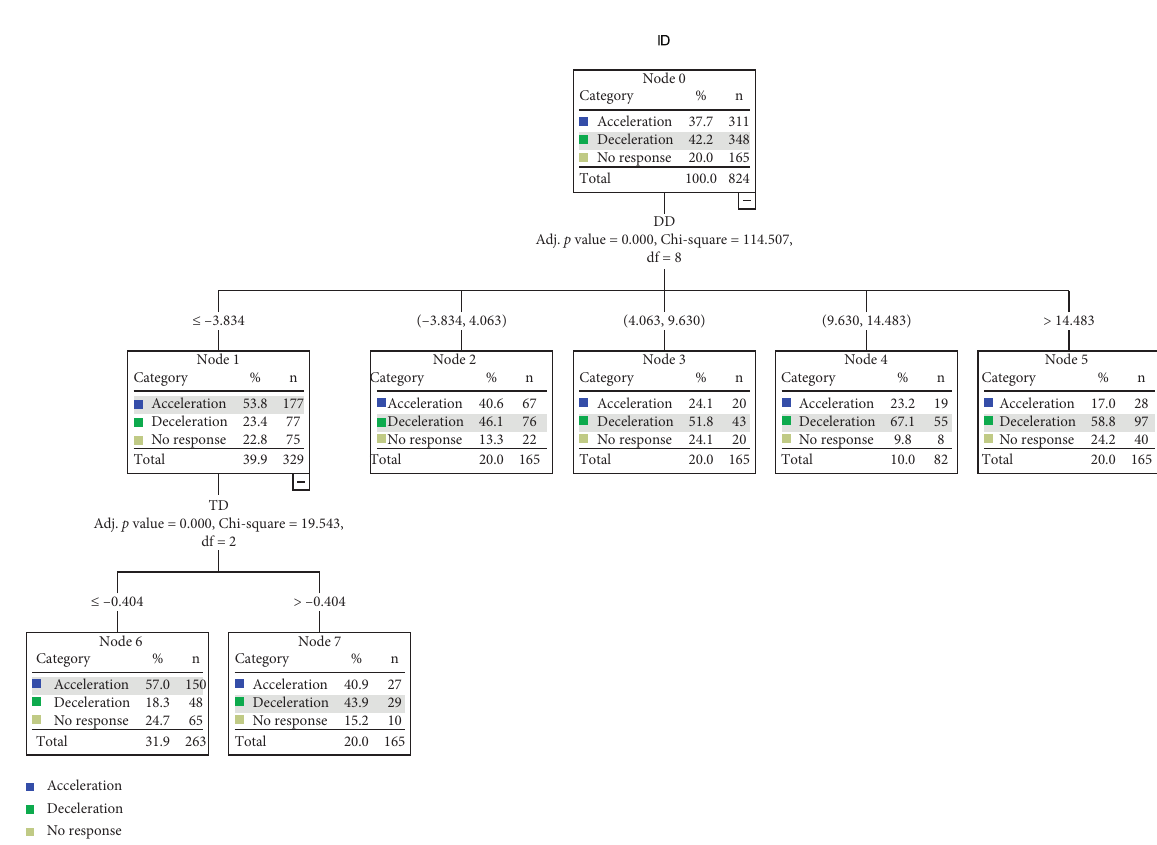
Figure 8: Classification tree result of ID.